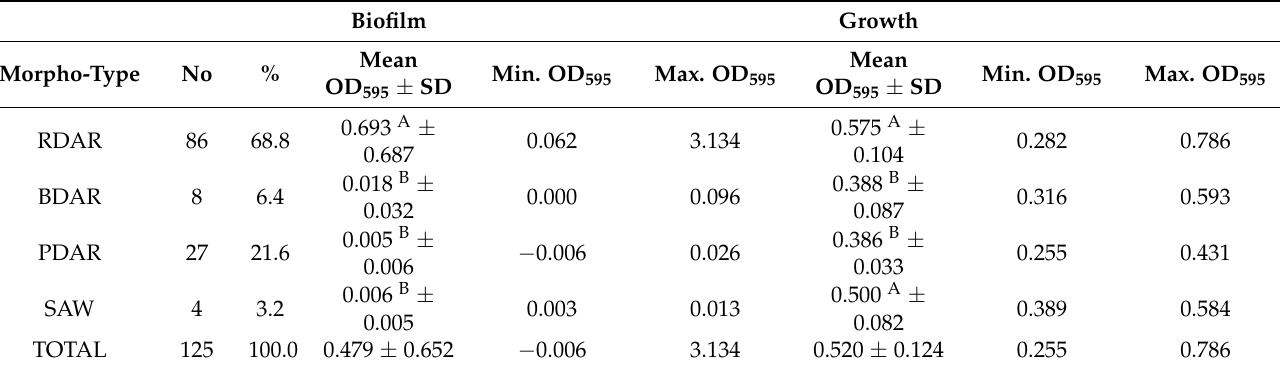
Table 3. Biofilm production and planktonic growth by extended-spectrum cephalosporin-resistant (ESCR) E. coli strains, as indicated by OD 595 in the crystal violet biofilm assay, within each morphotype and in the total material. Biofilm